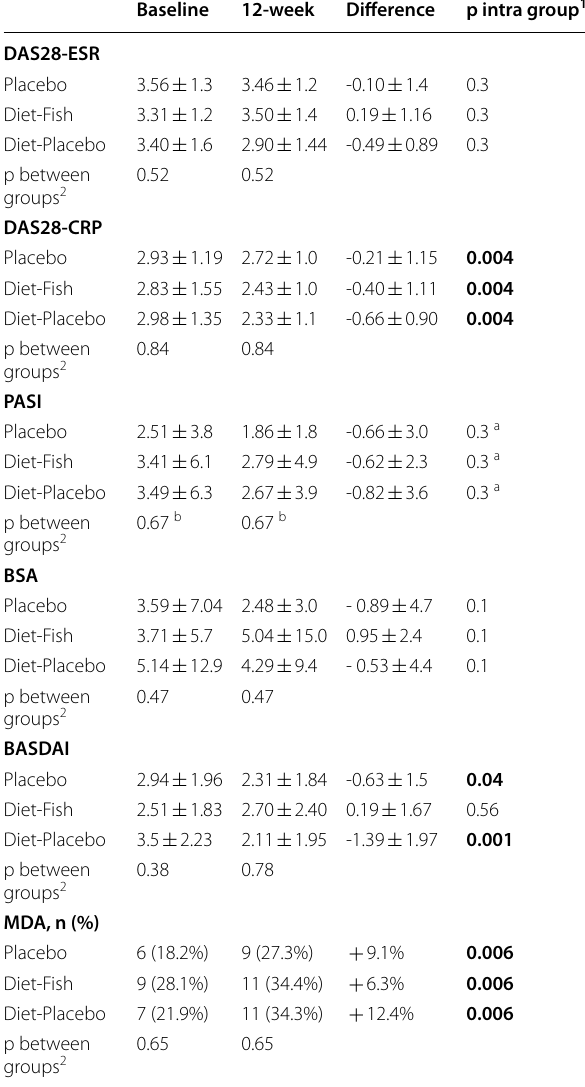
Table 2 Skin and joint disease activity outcomes before and after a 12-week dietetic